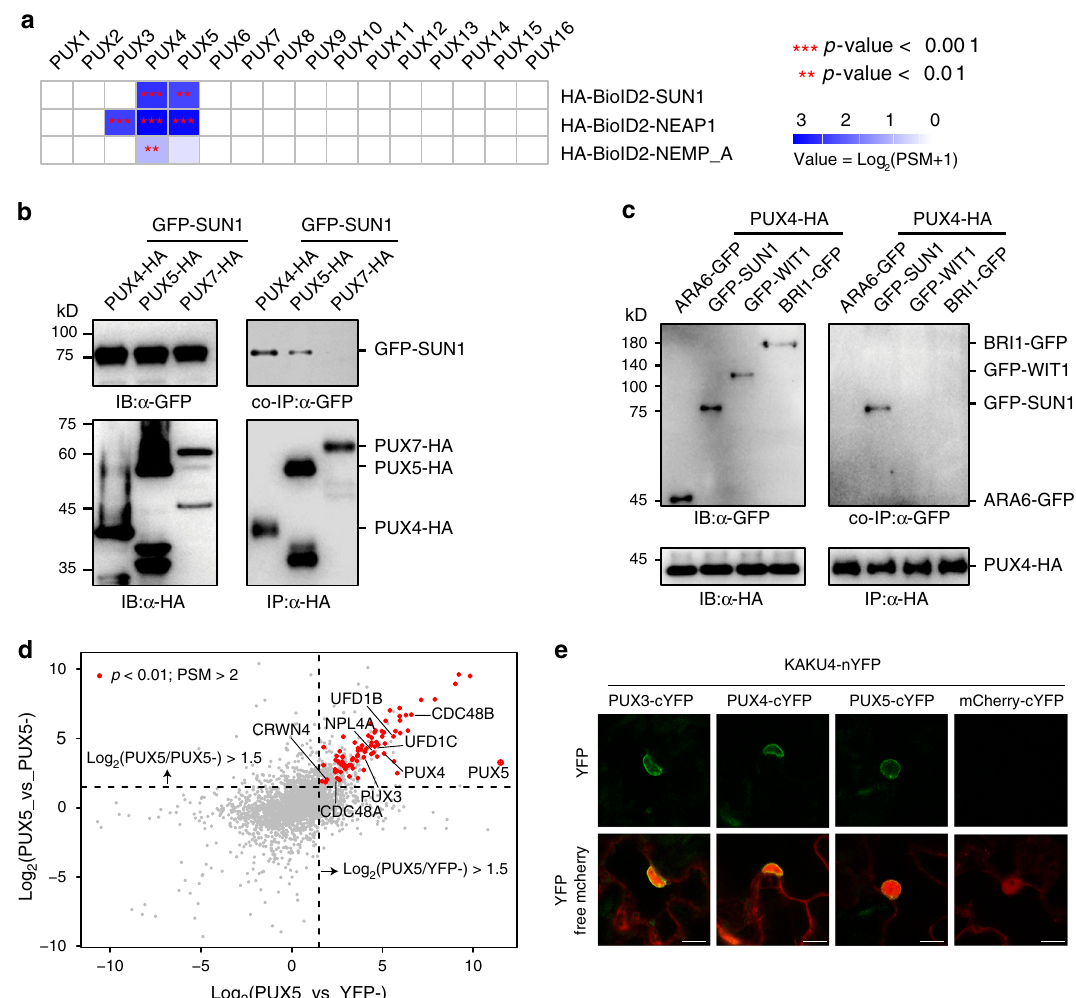
Fig. 3 PUX3/4/5 selectively associate with the INM via interaction with the nucleoskeleton. a Transformed and averaged PSM data of all AtPUX proteins from PL-LFQMS pro fi ling using Arabidopsis plants expressing BioID2-tagged INM protein SUN1, NEAP1, and NEMP_A. Three biological replicates were used. Asterisks (**, ***) represent signi fi cant enrichment with p -value < 0.01 and 0.001 (linear model F -test) compared to controls. b SUN1 speci fi cally associates with PUX4 and PUX5 but not PUX7. GFP-SUN1 was transiently coexpressed with PUX4-HA, PUX5-HA, or PUX7-HA in N. benthamiana . Protein extract was immunoprecipitated with anti-HA antibody-conjugated agarose beads before immunoblotting with anti-HA and anti-GFP antibodies. c PUX4 associates with SUN1 but not with ARA6, WIT1, and BRI1. PUX4-HA was transiently coexpressed with GFP-SUN1, GFP-WIT1, ARA6- GFP, or BRI1-GFP in N. benthamiana . Protein extract was immunoprecipitated with anti-HA antibody-conjugated agarose beads before immunoblotting with anti-HA and anti-GFP antibodies. d Scatter plot showing signi fi cantly enriched proteins (red dots) identi fi ed by PL-LFQMS pro fi ling using PUX5 as the bait. PUX5-BioID2-HA without biotin treatment (PUX5 − ) and YFP-BioID2-HA without biotin treatment (YFP − ) were used as controls. Three biological replicates were used. Candidates with PSM > 2 were further fi ltered using cutoffs log 2 FC > 1.5 and p -value < 0.01 (linear model F -test) compared to both controls. e BiFC assays showing interactions between PUX3/4/5 and KAKU4 at the nuclear periphery. BiFC YFP constructs together with free mCherry were transiently coexpressed in N. benthamiana , and epidermal cells were imaged. Bars = 10 μ